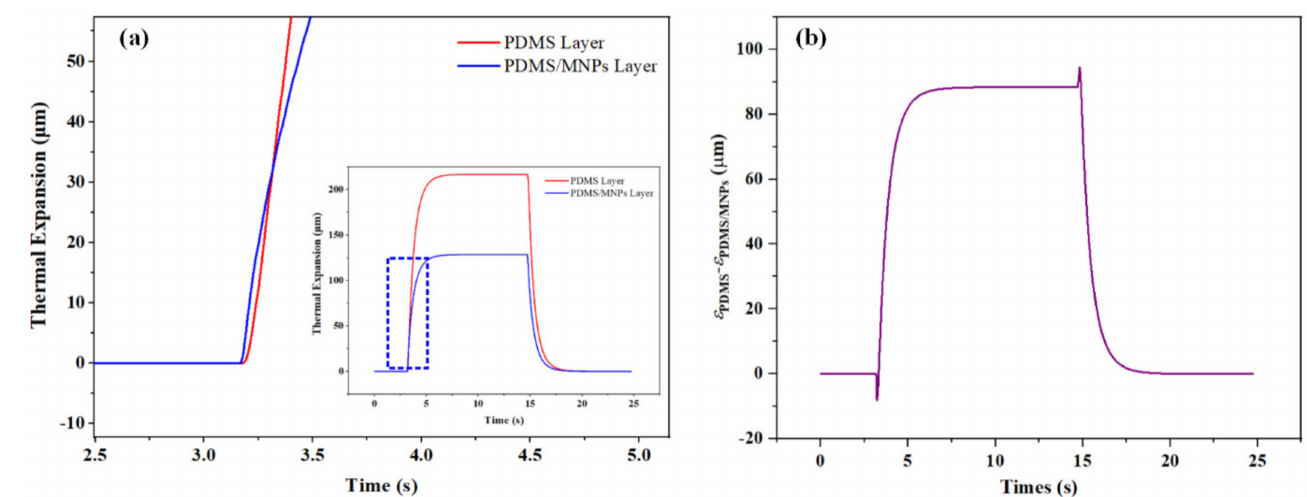
Figure 3. Two-step bending process analysis. ( a ) Thermal expansion curves of the PDMS layer and the PDMS/MNPs layer. ( b ) Differences in thermal expansion of these two layers for demonstrating the two-step bending process. It is not the actual photomechanical deflection, instead a kind of relative